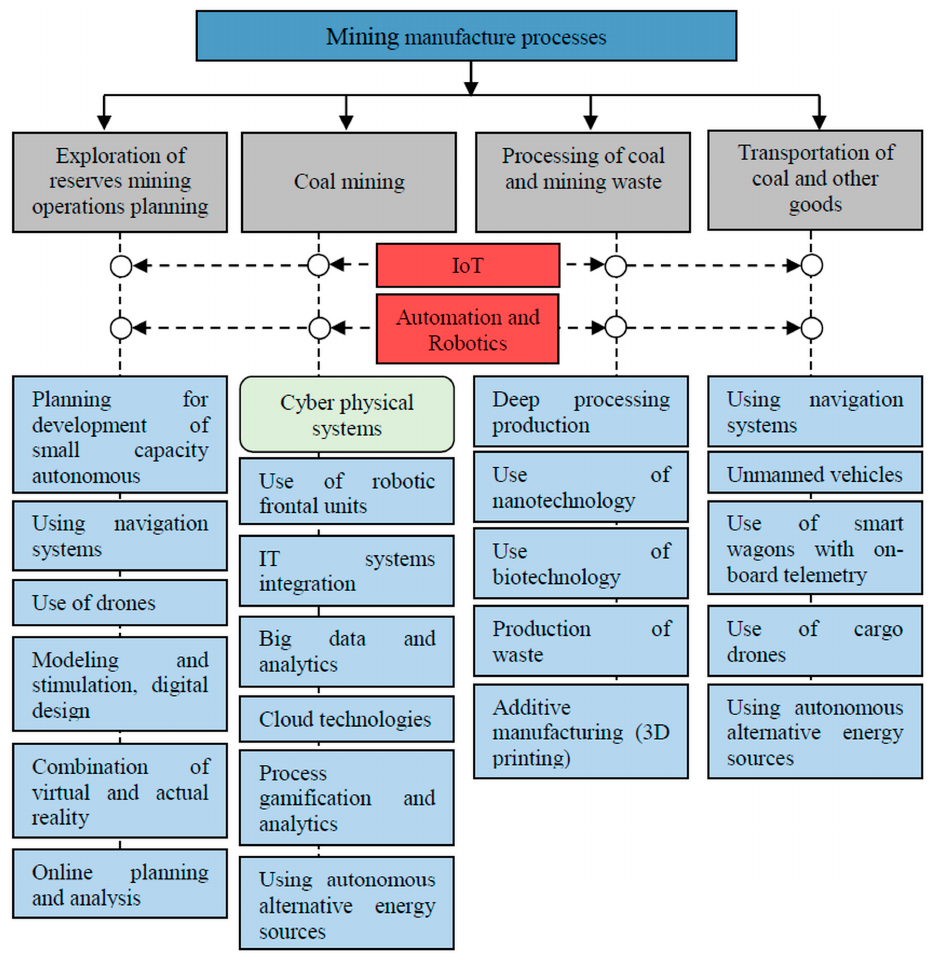
Figure 1. Core and segments of Industry 4.0 in mining industry (Reprinted from Ref. [16]). Along with the qualitative features mentioned above, the quantitative feature of Min- ing 4.0 is the acceleration of mining growth due to technology-driven productivity